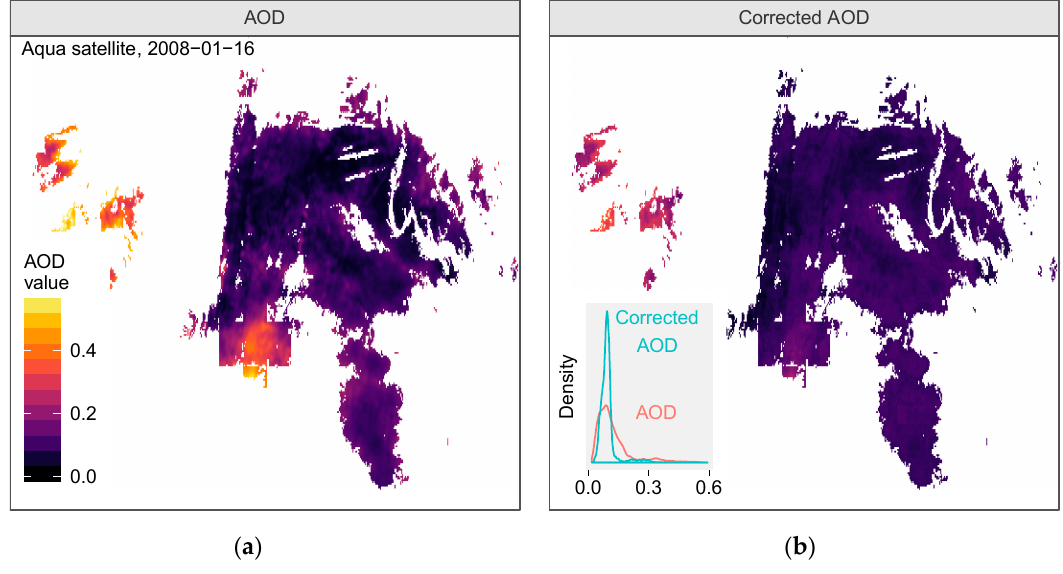
Figure 3. Maps of MAIAC AOD for 2008-01-16 ( a ) before; and ( b ) after correction with our XGBoost measurement error prediction model. The inset shows the density of AOD within this scene.